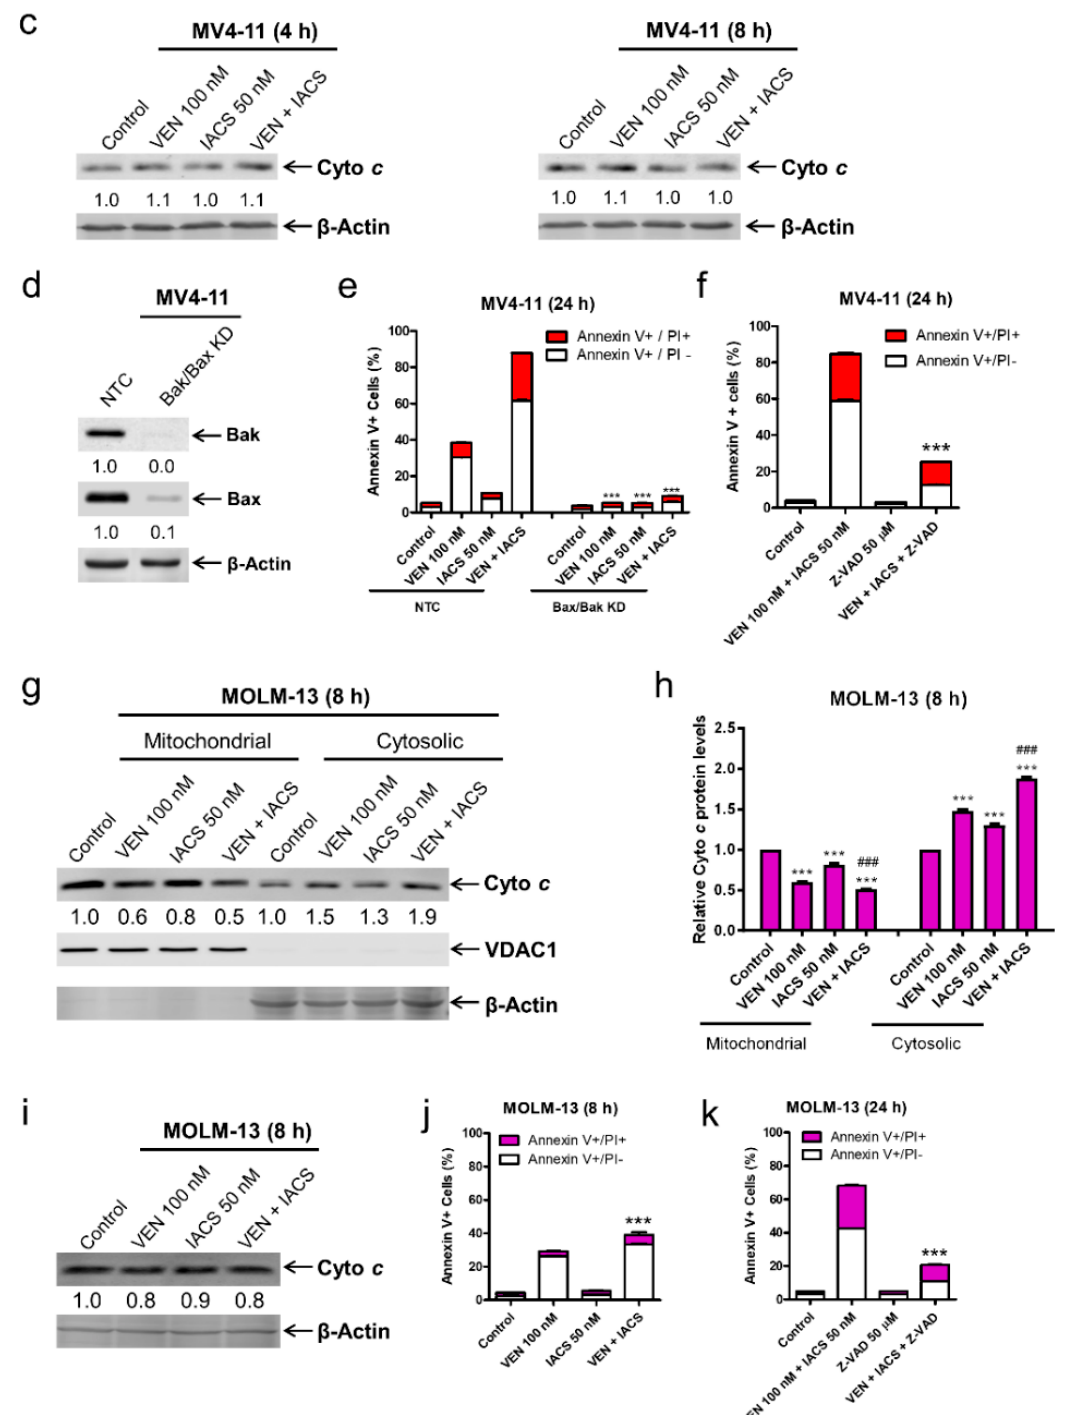
Figure 5. IACS-010759 and venetoclax cooperatively induce intrinsic apoptosis. ( a , b ) MV4-11 cells cultured in media supplemented with glucose were treated with vehicle control, IACS-010759, venetoclax, or in combination for 4 or 8 h. Cellular fractionation was performed. Mitochondrial and cytosolic fractions were subjected to western blot analysis. This experiment was performed 2 independent times in triplicate. One representative image is shown. Relative densitometry measurements were determined using Odyssey Software V3.0, normalized to β -actin or VDAC1, and compared to the vehicle control. Results from one representative experiment are graphed as mean ± SEM in panel b. * indicates p < 0.05, ** indicates p < 0.01, and *** indicates p < 0.001 compared to vehicle control; ### indicates p < 0.001 compared to single drug treatments. ( c ) MV4-11 cells were cultured and treated as described in panel a. Whole cell lysates were subjected to western blot analysis. Relative